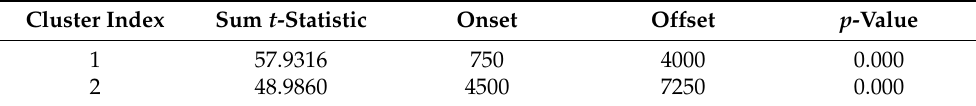
Table 6. Significant clusters for chance comparison permutation analysis collapsed across all four of the permutations. The threshold of significance for our cluster masses as determined by the permutation analyses was